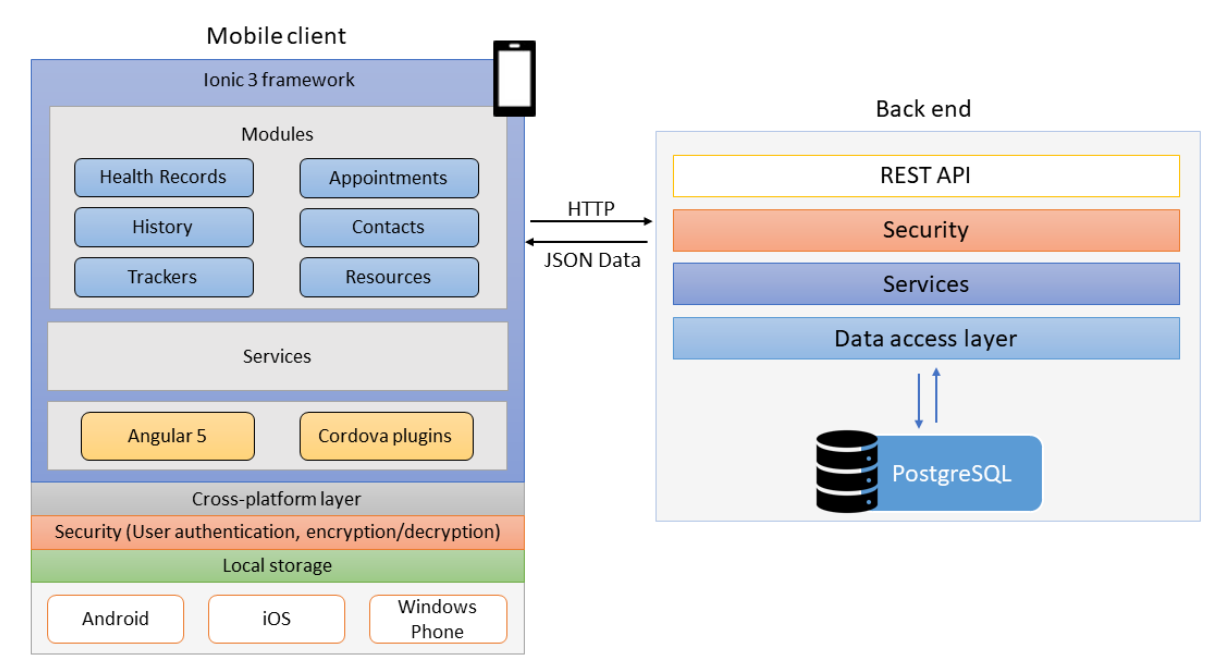
Figure 1. System architecture of the mobile personal health record app. REST: REpresentational State Transfer; HTTP: HyperText Transfer Protocol; API: application programming interface; JSON: JavaScript Object